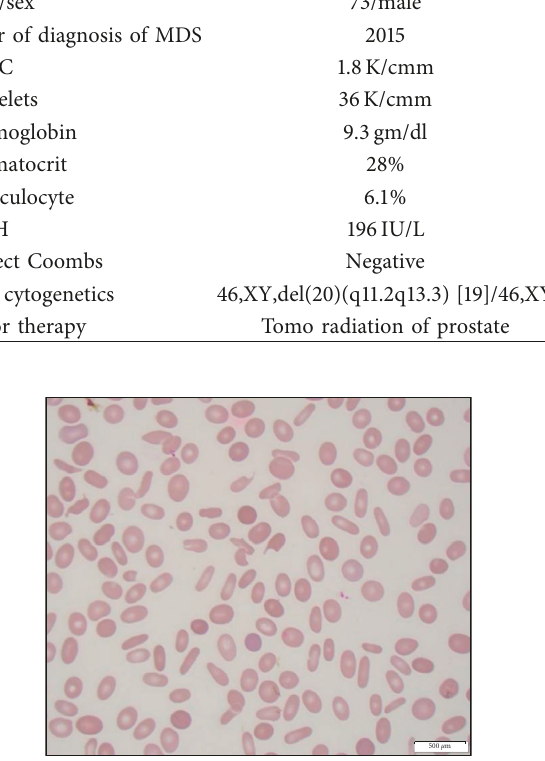
Figure 1: Peripheral smear showing frequent elliptocytes, tear drop cells, schistocytes, and occasional